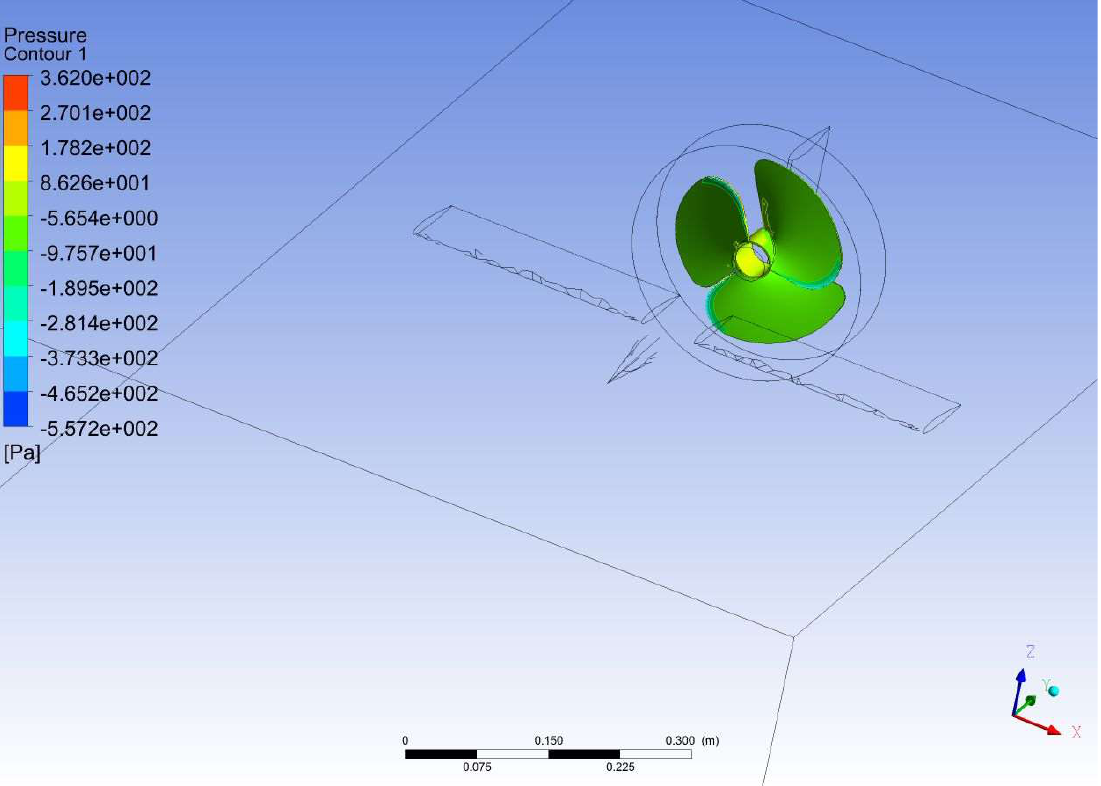
Figure 40. Aerodynamic pressure impacts on rotating propeller—steady level flight.